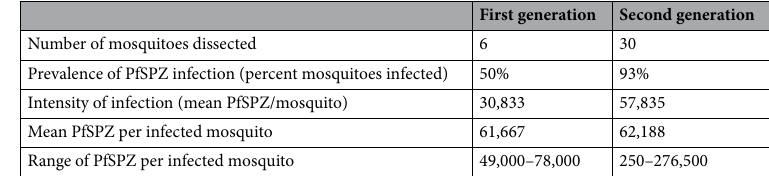
Table 1. P. falciparum infection of adult A. stephensi derived from cryopreserved eggs. Adult mosquitoes grown from cryopreserved eggs and second-generation adults reared from eggs laid by those first generation cryopreserved mosquitoes were fed on cultured stage V Pf gametocytes, and the numbers of sporozoites (PfSPZ) in the salivary glands were determined 14 days